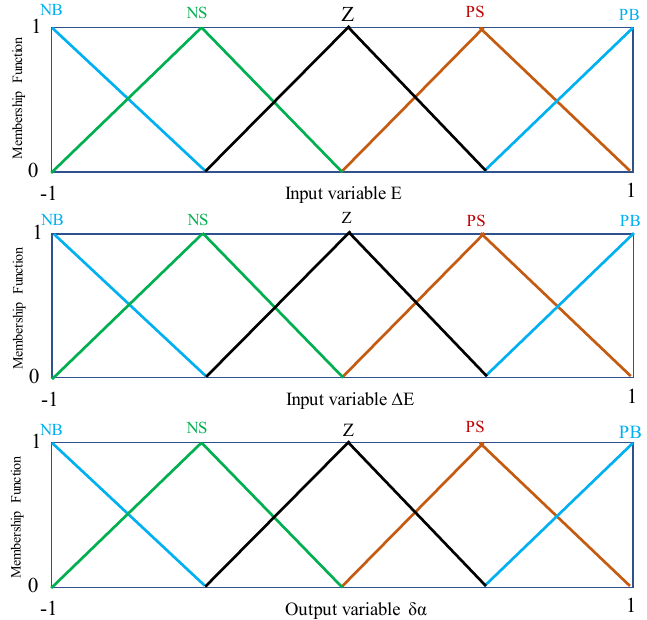
Figure 10. Membership functions of the input (E, ∆E) and output (δα) variables. The triangular membership function is chosen for all fuzzy sets because of its simplicity.